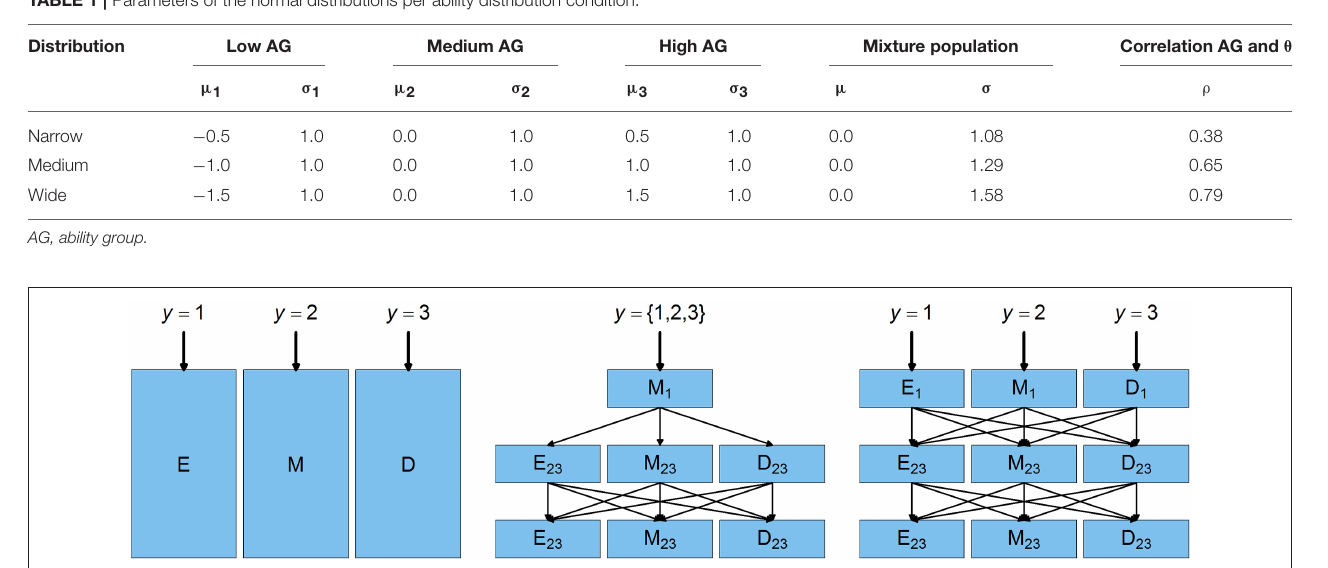
TABLE 1 | Parameters of the normal distributions per ability distribution condition.